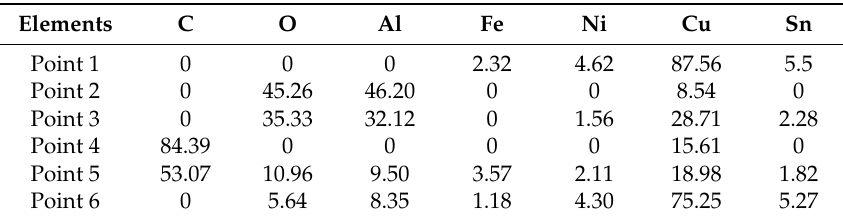
Table 2. Summary of Energy-dispersive spectrometer(EDS) analysis conducted at selected locations shown in Figure